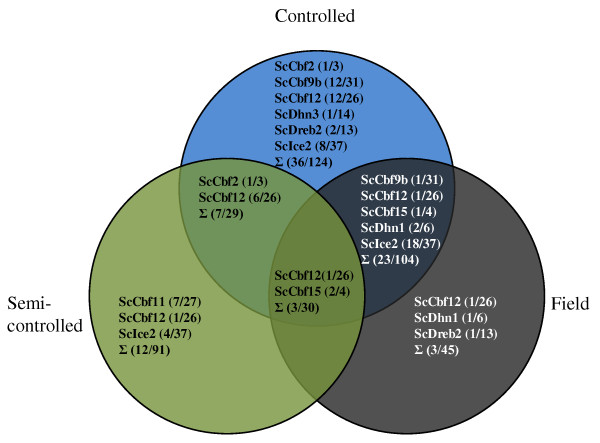
Venn diagram of SNPs from candidate genes significantly (P < 0.05) associated with frost tolerance in three phenotyping platforms. The first and second numbers in each bracket are the number of significant SNPs and total number of SNPs in each candidate gene.